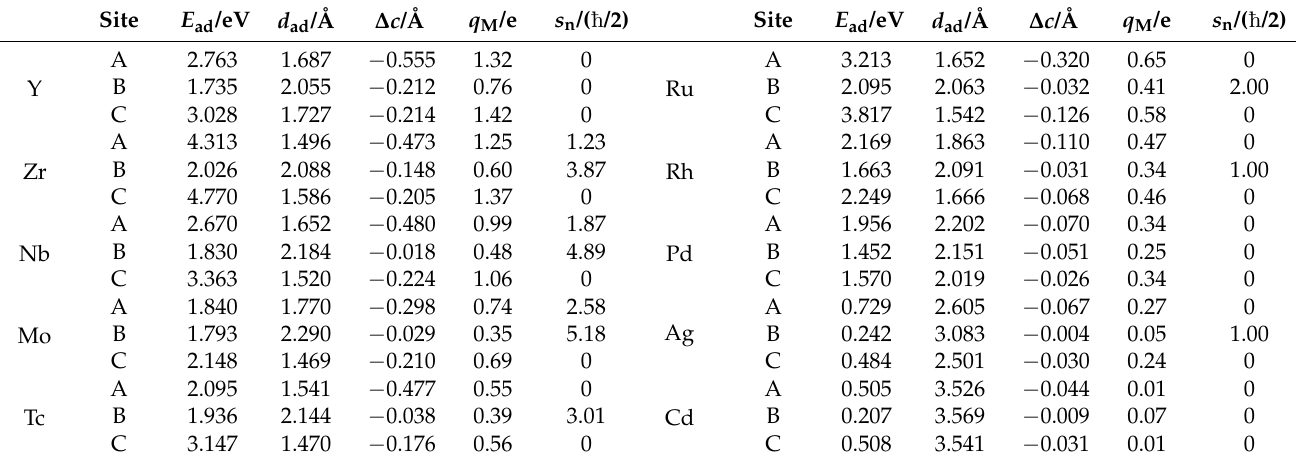
Table 1. Adsorption energy ( E ad /eV), adsorption distance to the graphene sheet ( d ad /Å), warpage of graphene sheet ( ∆ h /Å), Mulliken charge ( q M /e) populated on transition atom, net spin ( s n /( è /2)) of single-layer graphene adsorbing 4 d -transition metal atoms on atomic-carbon (A), bridge (B) and center (C) sites,